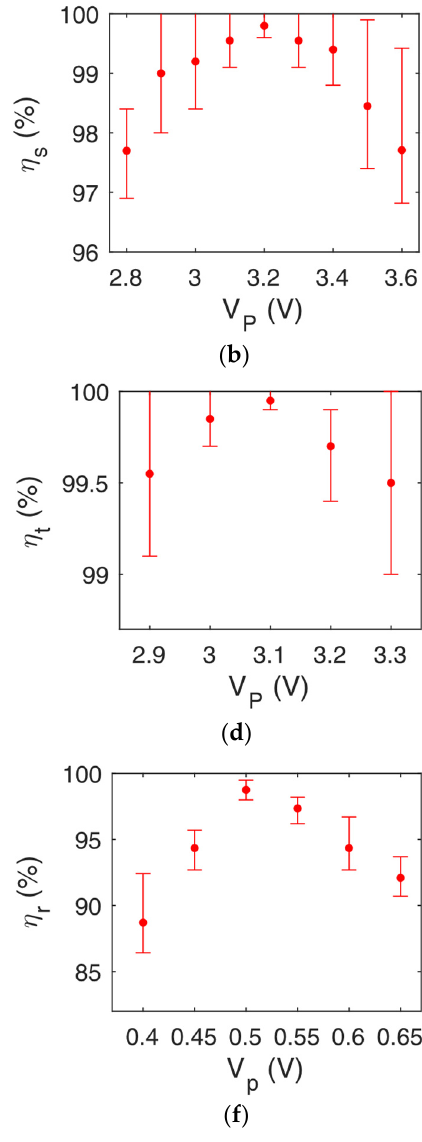
Figure 5. η s,t,r vs. V P for ( a – b ) squared, ( c – d ) trapezoidal, and ( e – f ) rounded electrodes shaping for f = 2 MHz. The red dots represent the average value after dozens of simulations, with a variance sketched with error bars to take into account stochastic e ff ects.